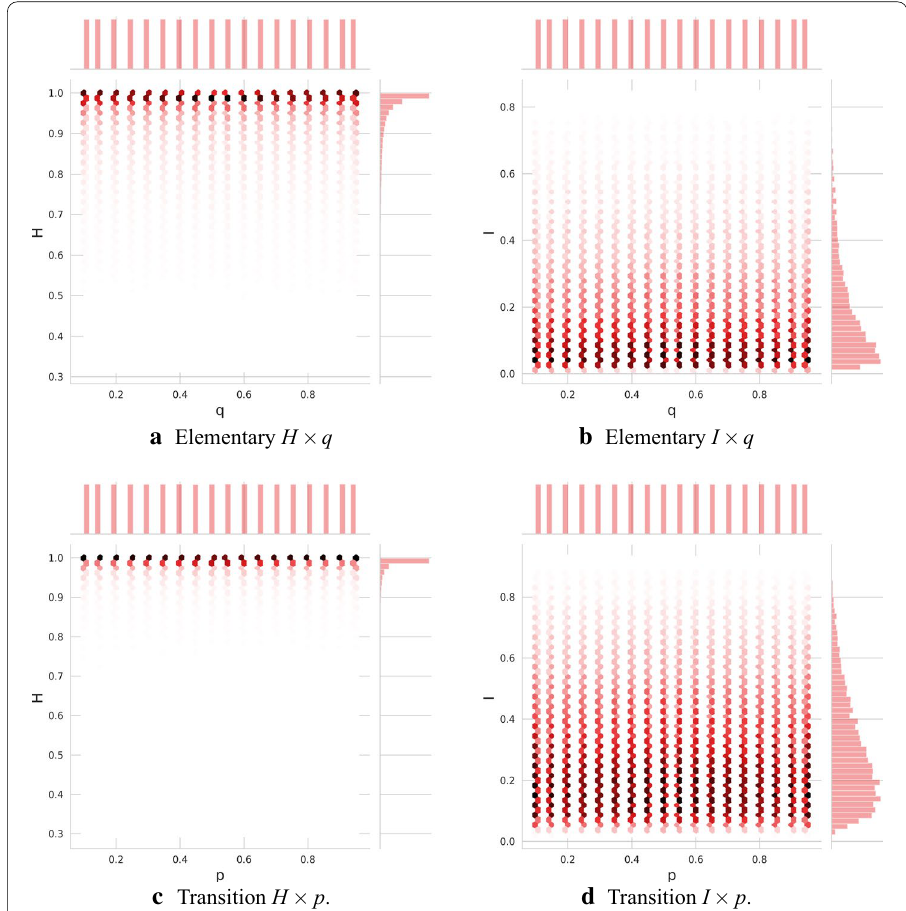
Fig. 20 From the computation of entanglement over elementary layers ( a , c , d ) and transition coupling ( b , e , f ), we see no dependency on parameters p and q